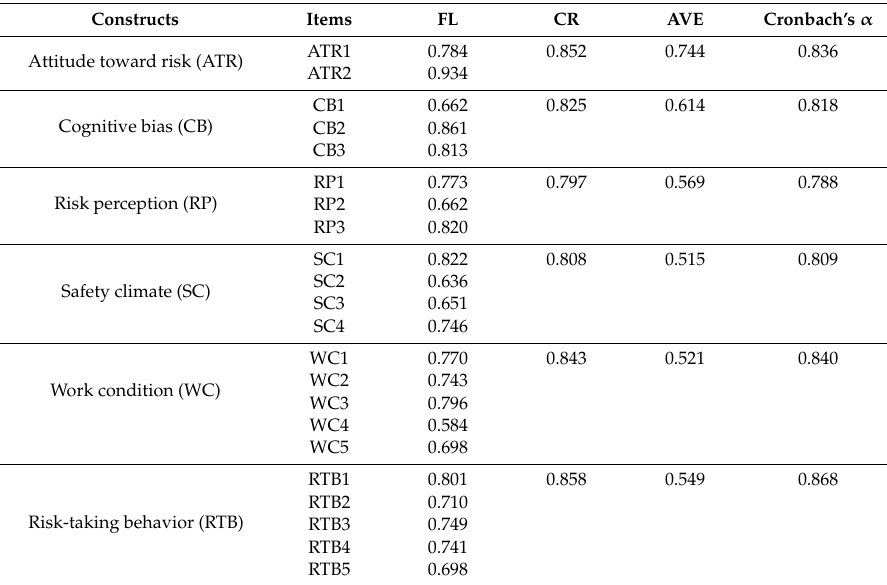
Table 3. Construct reliability and convergent